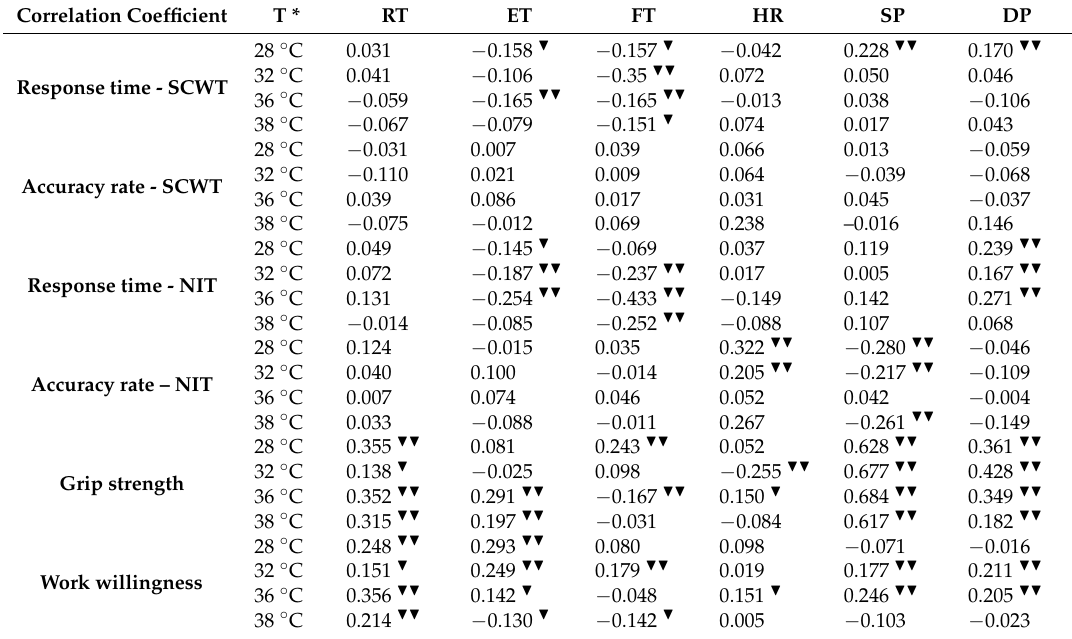
Table 5. Correlation analysis results of work efficiency indices and physiological